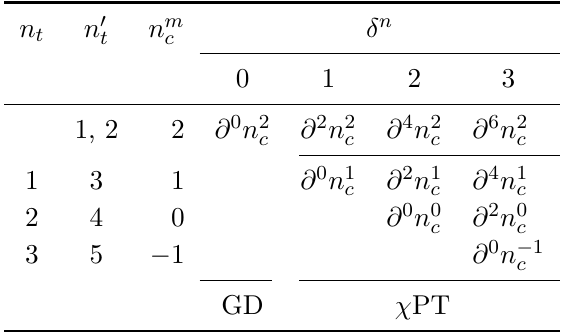
counts the same number t = min(4 − n 0 , 2) and that χ PT t t